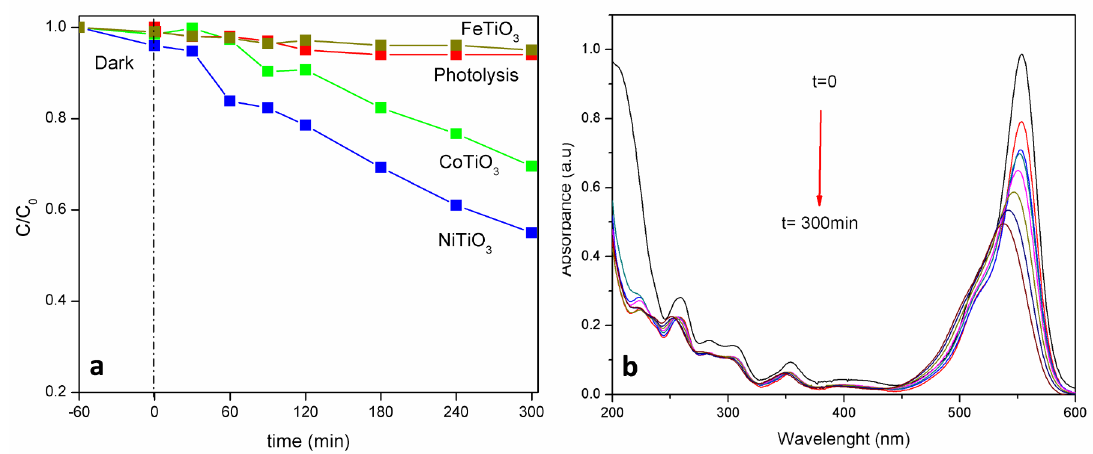
, CoTiO , and NiTiO monitored 3 3 3 . 3